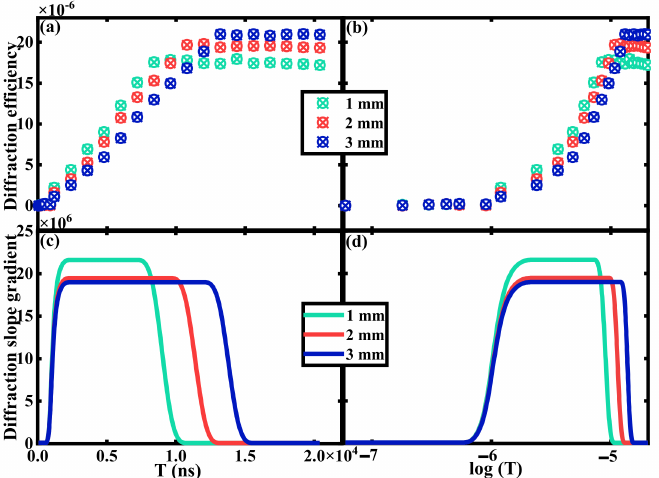
Figure 4. Temporal diffraction characteristics of HRE by ns level exposure with ( a ) linear abscissa (T), ( b ) logarithmic abscissa (log(T)), and the diffraction slope gradient with ( c ) linear abscissa (T) and ( d ) logarithmic abscissa